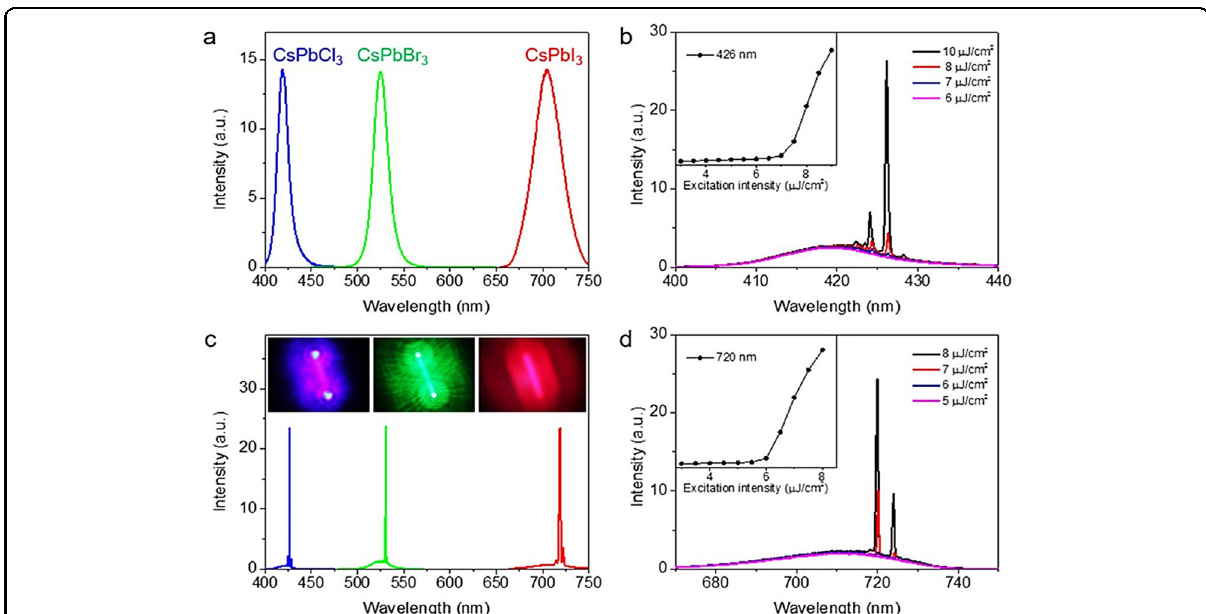
Fig. 7 Wavelength tunability of 1D MHP NWs based lasers. a Wavelength tunability of 1D MHP NWs. b Emission spectra of single CsPbCl 3 NWs. c Wavelength tunability of inorganic MHP NW lasers. d Emission spectra of single CsPbI 3 NWs. Reproduced with permission from ref. 79 . Copyright 2016, American Chemical